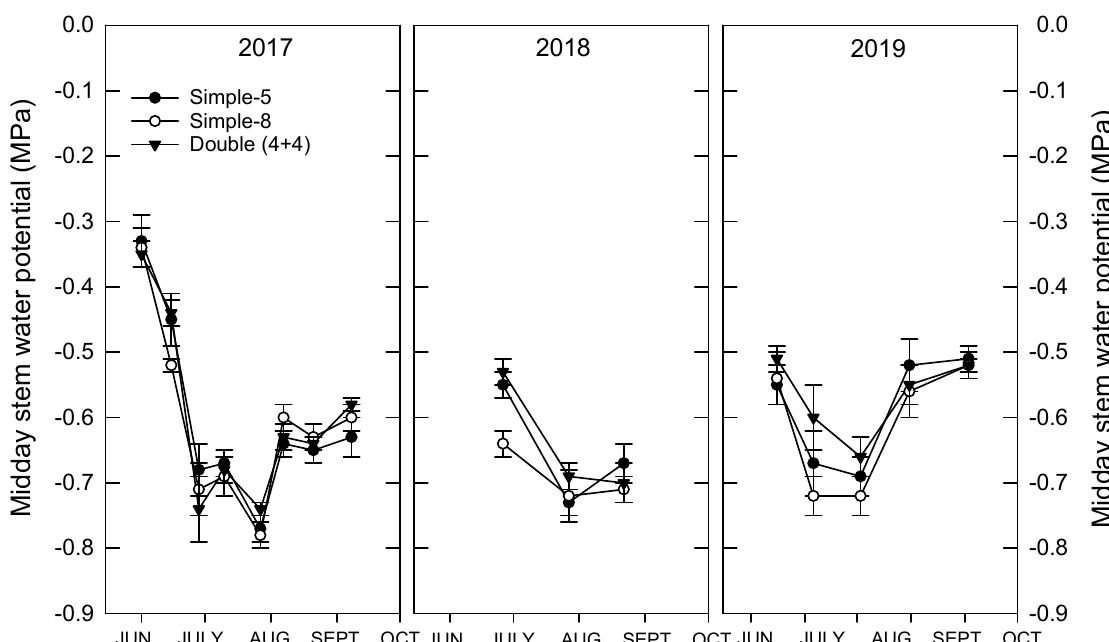
-0.9 JUN. JULY AUG. SEPT. OCT. JUN. JULY AUG. SEPT. OCT. JUN. JULY AUG. SEPT. OCT. Figure 2. Seasonal variation for midday stem water potential in the different irrigation treatments in the persimmon trial. Error bars are the standard error. Table 5. Effects of the different irrigation regimes on the relative trunk growth during the entire experimental season and canopy volume measured at the end of the experiment. In the lemon trial, the statistical significance for the different factors included in the ANOVA is also included. ***, *, and n.s., mean significant differences at p < 0.001, p < 0.1, and non-significant differences between treatments, respectively. In the persimmon trial, different letters indicate significant differences between treatments.